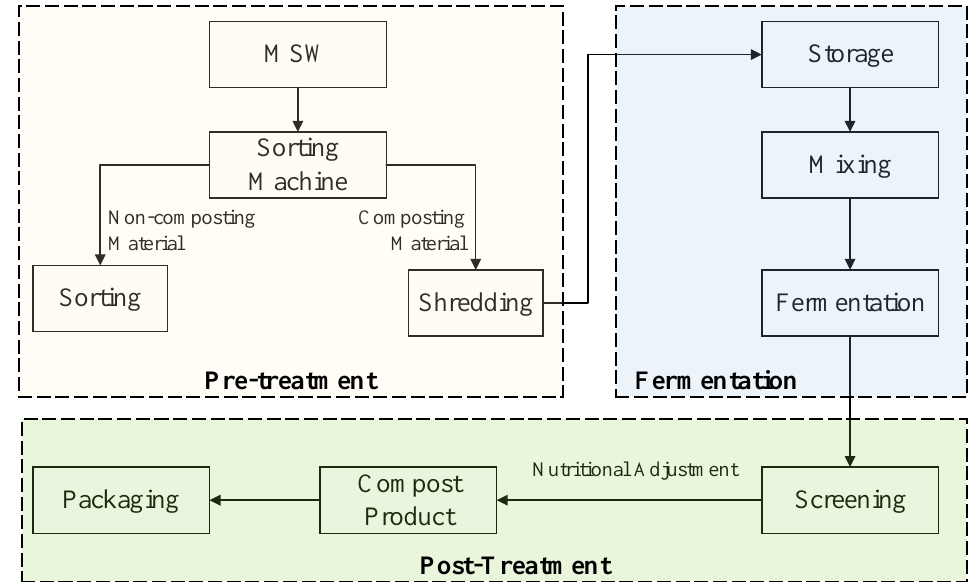
Figure 4. Schematic processing flowchart of municipal solid waste (MSW) composting. [70].